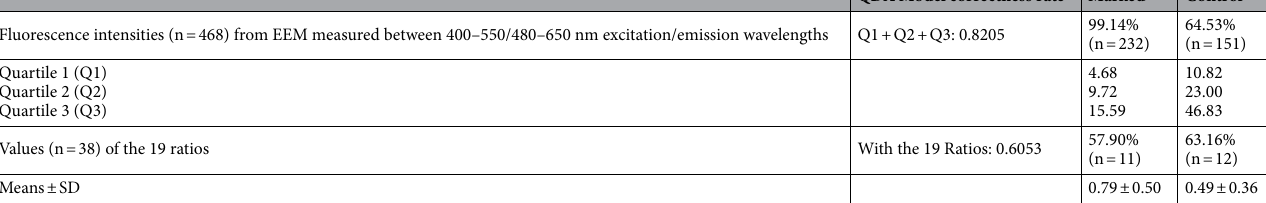
Table 1. Results from quadratic nonlinear discriminant analysis (QDA). QDA to assign to a glass eel group EEM fluorescence intensities measured in the alizarin maximum bands and values of the ratios R. The model correctness rate, the percentages of each assignation (with the number of observations in parentheses), the fluorescence intensities quartiles and the ratios values means ± SD are presented for each